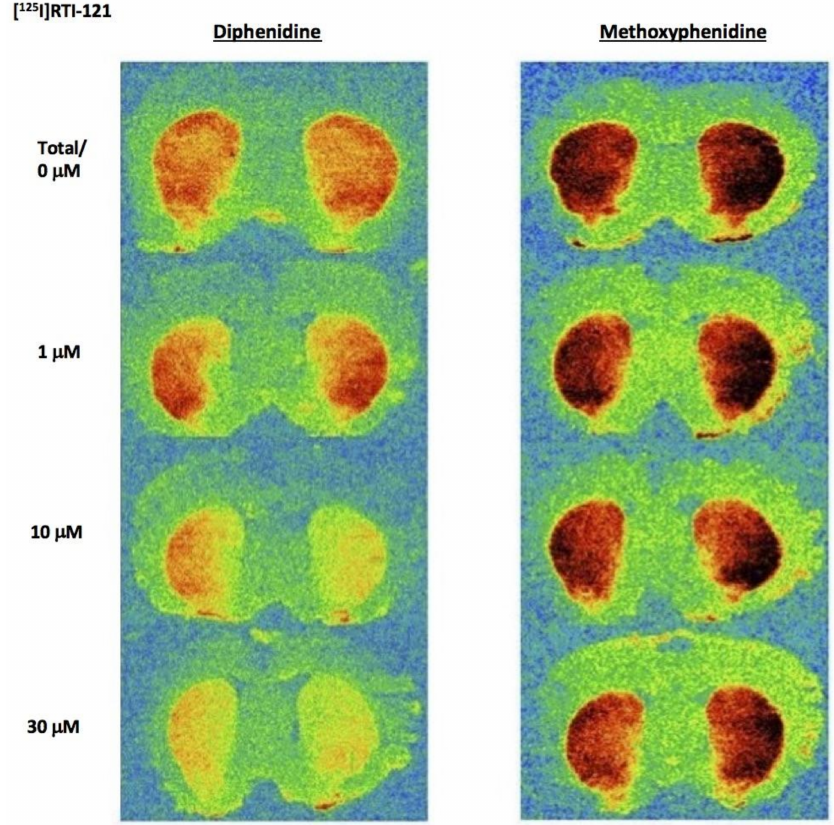
Figure 3. Representative autoradiograms showing the binding of the radioligand [ 125 I]RTI-121 in the brain striatal sections in the presence of increasing concentrations of DPH and 2-MXP